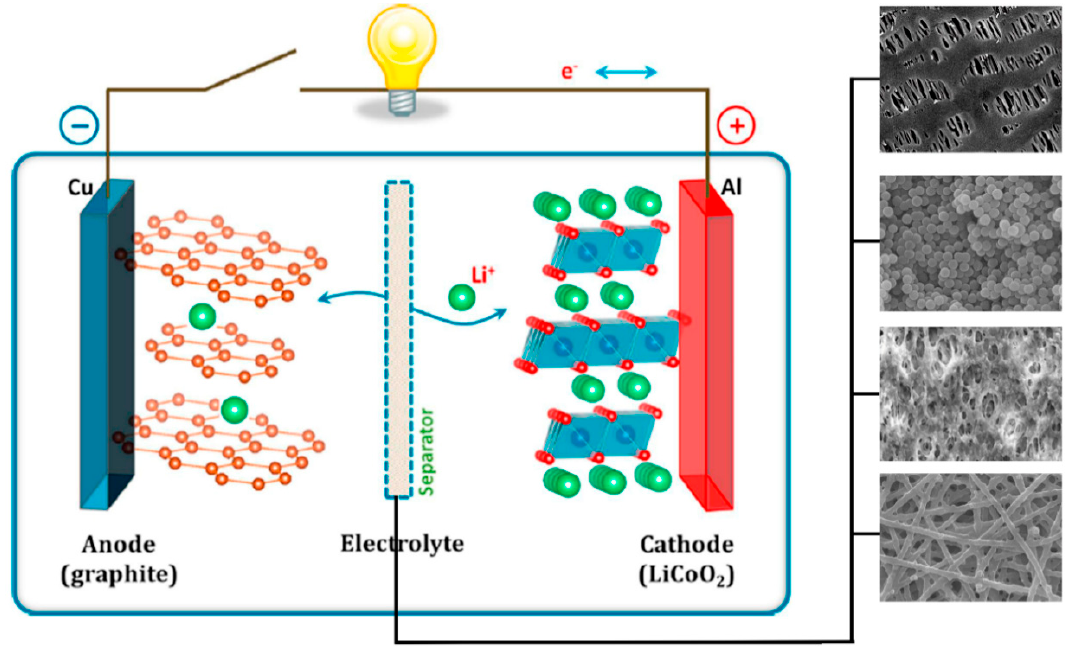
Figure 1. Schematic of Li-ion battery mechanism [1], with copyright permission from American Chemistry Society.